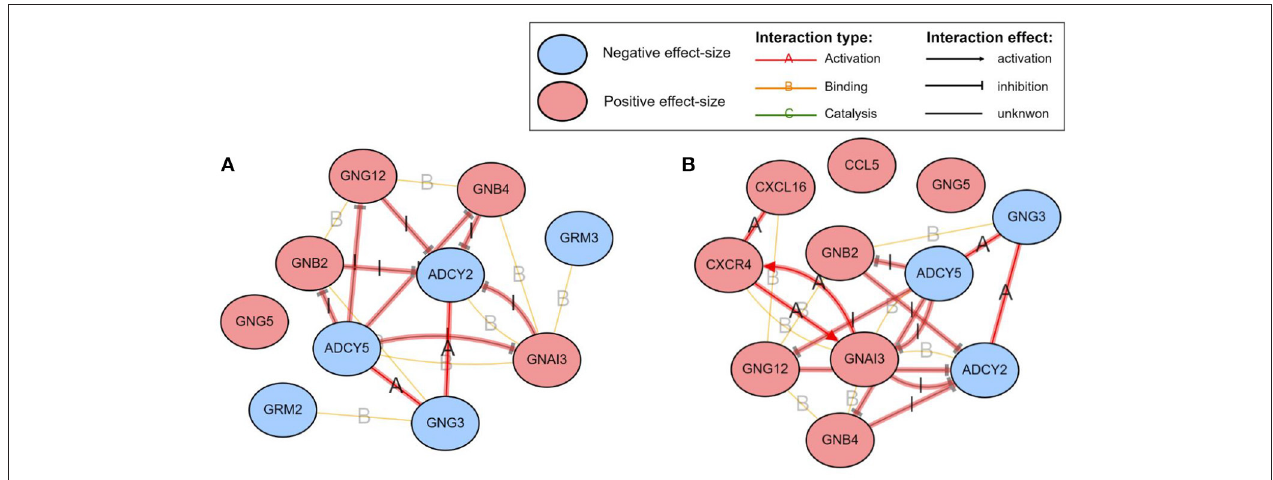
FIGURE 8 | The mechanisms involving the proposed GBM signature in the Glutamatergic synapse (A) and the Chemokine signaling (B) pathways, as identified by iPathwayGuide (www.advaitabio.com). The colors of the nodes represent the effect sizes obtained from the meta-analysis step described in Figure 1A . The edges represent molecular actions between the genes obtained from the STRING database. The edges highlighted in red indicate the coherent edges between the genes.